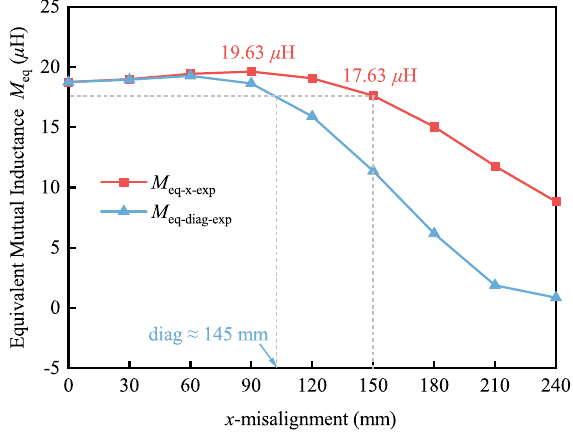
Figure 11. The experimental equivalent MIs under x - and diagonal-misalignments. Figure 12 presents the steady-state experimental waveforms of the input voltage V in and current I p , and output voltage V s and current I s under 50 mm, 100 mm, and 150 mm x -misalignment with R B = 15 Ω . As shown in Figure 11, the phase shifts change from 13 ◦ under 50 mm x -misalignment to 19 ◦ under 150 mm x -misalignment, which are acceptable in practice considering the measurement errors of the components. Therefore, the system can be considered to achieve the ZPA input. Furthermore, the amplitude of I s has a maximum change of 13.33% from 6.0 A to 6.8 A under 150 mm x -misalignment compared with the well-aligned condition shown in Figure 10. However, the variation is only 0.8 A, which is allowable and so small that the system can be regarded as CC output. Therefore, the CC output of the proposed design can be maintained within 50% of the length of the Rx coil misalignment range.